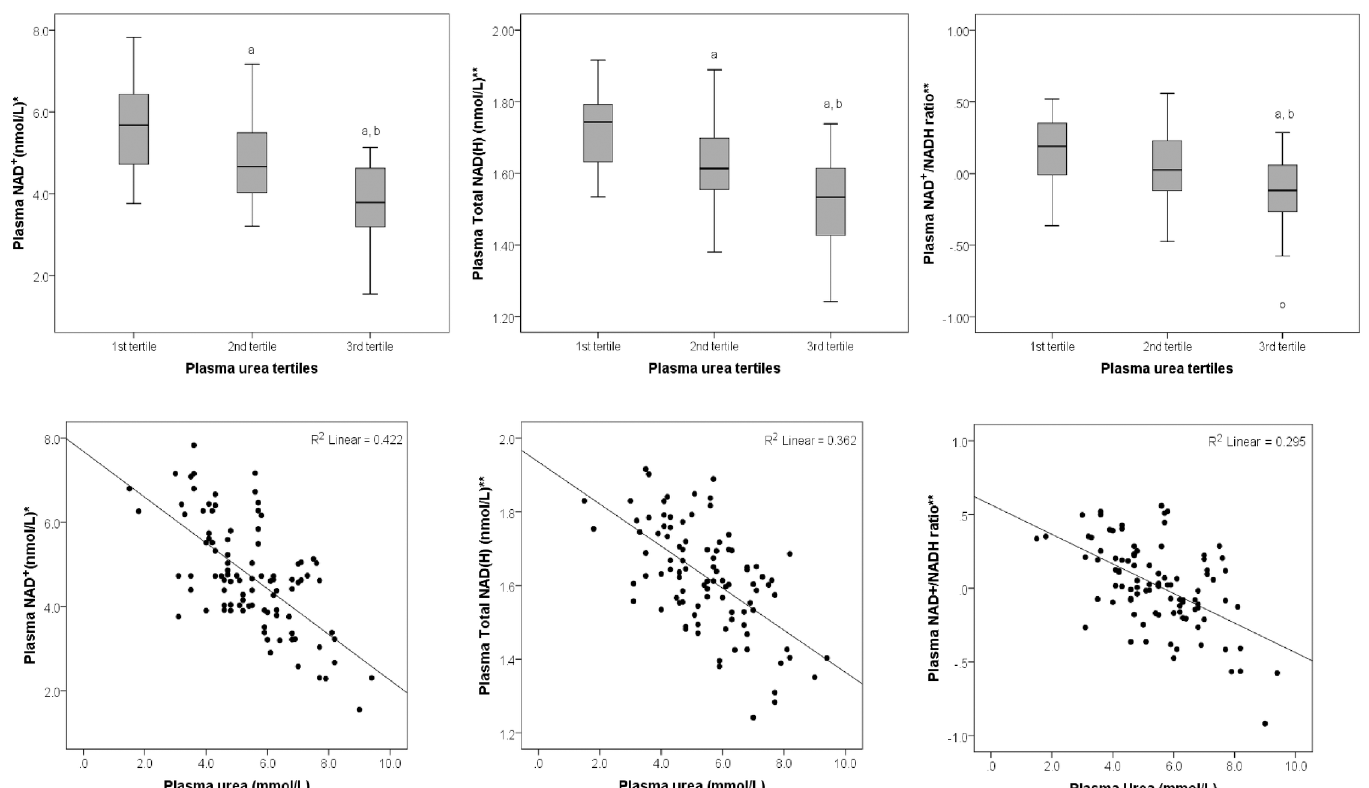
Fig 2. Mean plasma levels of NAD + , Total NAD(H), and NAD + /NADH ratio across tertiles of plasma urea (on the left), and corresponding linear graphs for the association between levels of plasma urea, and NAD + , Total NAD(H) and NAD + /NADH ratio (on the right). (cid:3) Data represented as square root NAD + , (cid:3)(cid:3) Data represented as base-10 log-transformed Total NAD + and NADH, and NAD + /NADH ratio. a significantly different compared to 1 st tertile, b significantly different compared to the 2 nd tertile.